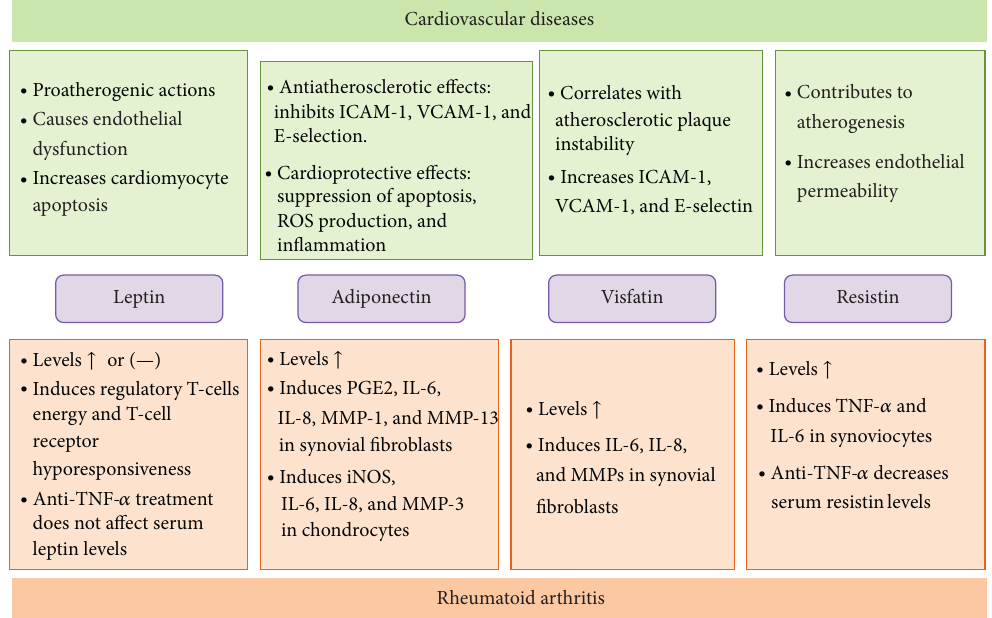
Figure 1: Schematic representation of the relations between adipokines, cardiovascular diseases, and rheumatoid